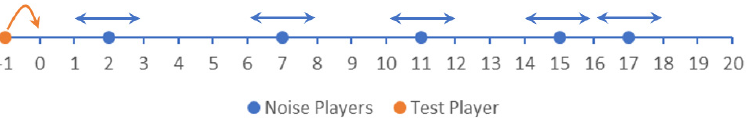
Figure 4. One dimensional simulation of traffic with a test player with a goal and in noisy environ- ment created by other players.